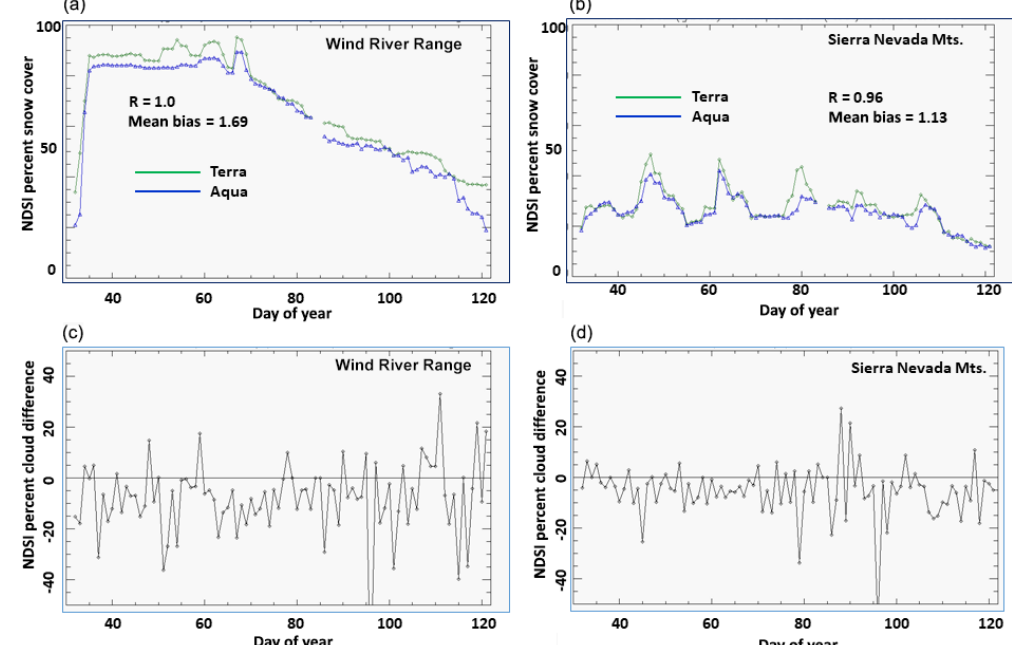
Figure 10. (a, b) Time-series plots of percent snow cover in a 22171km 2 scene (see location of the ROI that includes the Wind River Range, Wyoming, in Fig. 2) and in a 109575km 2 scene (see ROI that includes the Sierra Nevada Mountains, in Fig. 2) using M*D10A1F snow- cover maps for a time series extending from 1 February through 30 April (DOY 32–121) 2012. (c, d) Difference in percent cloud cover by day for Terra MODIS minus Aqua MODIS for the ROI including the Wind River Range and the ROI including the Sierra Nevada Mountains, corresponding to (a, b) , showing that the Aqua MODIS shows more cloud cover during the study period than the Terra MODIS